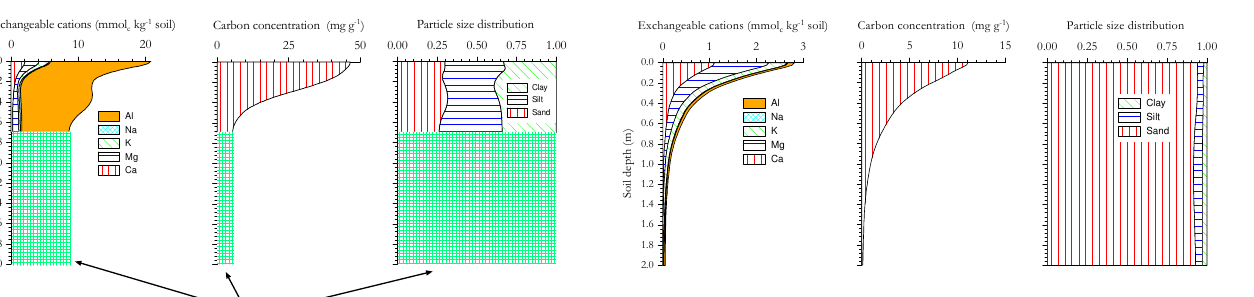
Fig. 18 Fig. 18. Profiles of exchangeable cations, soil carbon and texture for a Haplic Arenosol (Hyperdystric) in north Peru